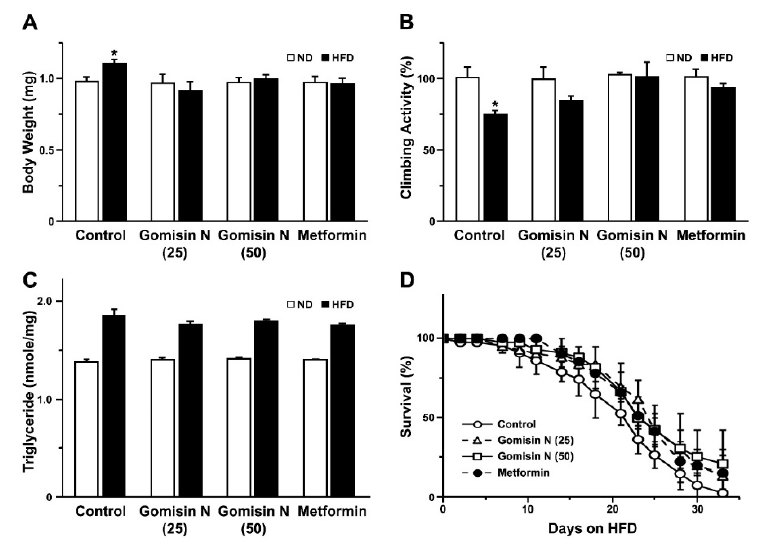
Figure 3. The effects of gomisin N on the HFD-induced phenotypes in adult flies. ( A – C ) The body weight ( A ), climbing activity ( B ), and levels of triglyceride ( C ) of adult flies fed either with an ND or HFD are shown for each rearing condition. Flies were treated with various concentrations of gomisin N or metformin for 2 weeks. ( D ) The life spans are shown for flies fed with an HFD with and without gomisin N or metformin. A total of 12 adult flies were included in each trial. Mean ± SEM are indicated for experiments repeated three times. *, p < 0.05.